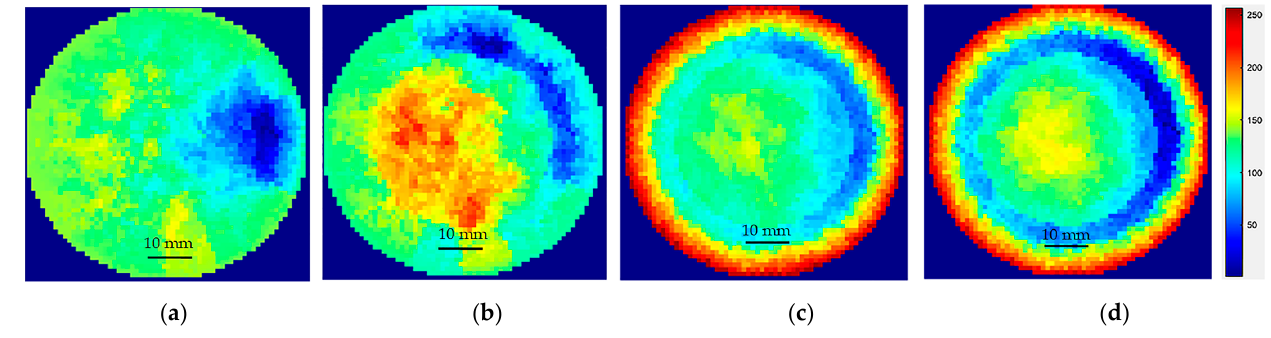
Figure 19. Blocking of the sensor due to sucrose crystallization over the ERT electrodes ( a ) 90 ◦ C; ( b ) 45 ◦ C; ( c ) 40 ◦ C; ( d ) 35 ◦